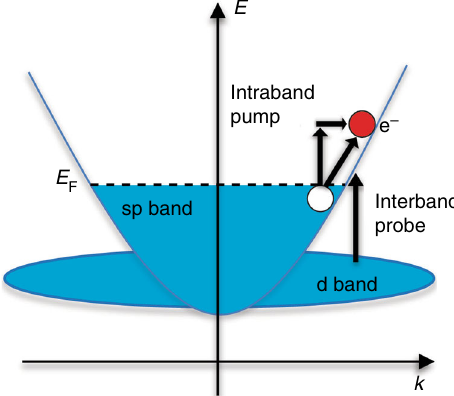
Fig. 1 Schematic of the energy band structure and electronic transitions of gold. Arrows indicate an intraband transition in the conduction band initiated by the pump, and an interband transition between the d and conduction bands due to the probe. The creation of an energetic electron (red) and a hole (white) is